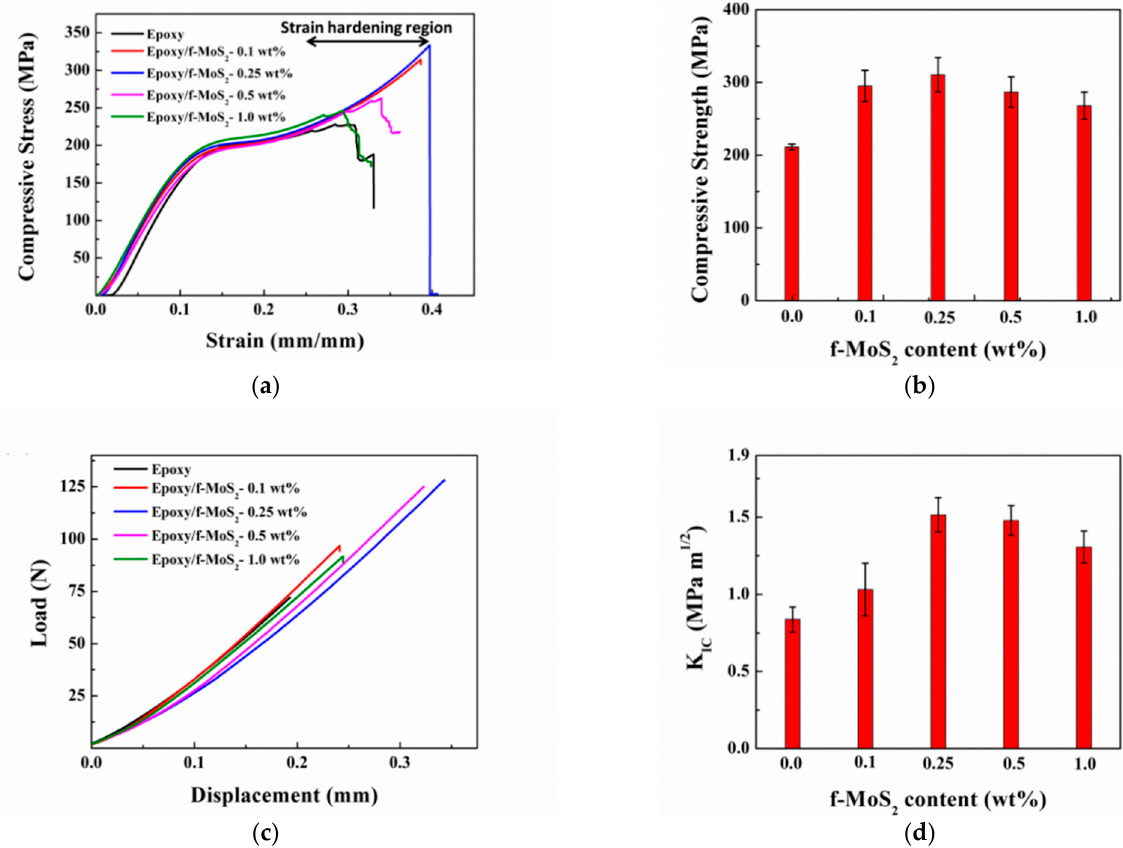
Figure 8. ( a ) Typical true stress versus strain curves for compression test and ( b ) compressive strength versus f-MoS 2 content of the Epoxy and Epoxy/f-MoS 2 nanocomposites. ( c ) Typical load-displacement curves from fracture toughness test &( d ) fracture toughness vs. f-MoS 2 content of the Epoxy and Epoxy/f-MoS 2 nanocomposites.